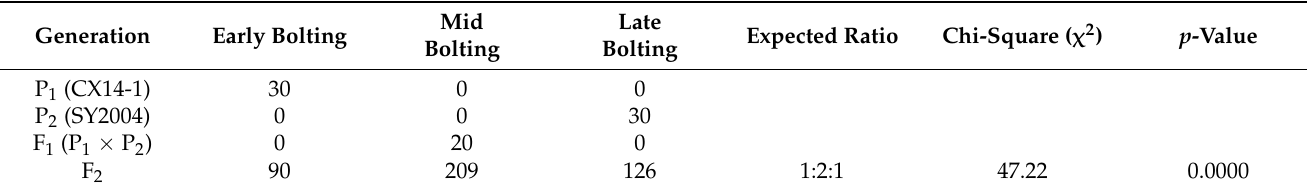
Table 1. Phenotype of the early-to late-bolting trait in a four-generation family, and the chi-square test ratio of segregation in the F 2